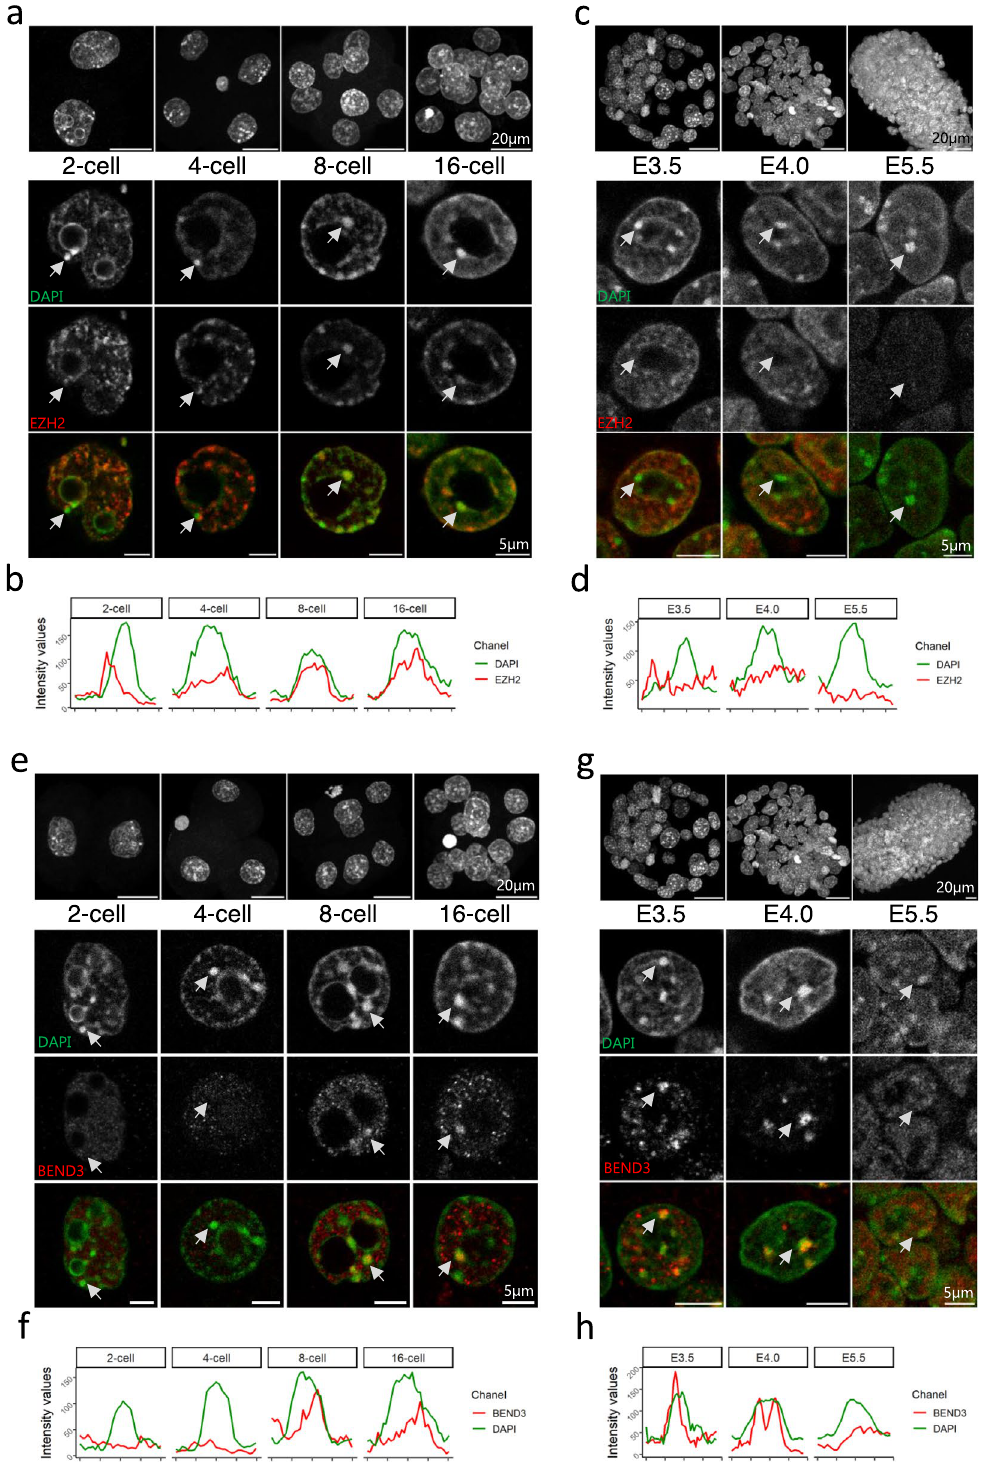
Figure 5. Patterns of EZH2 and BEND3 during peri-implantation development. ( a , c ) Upper panels show the Z-projection of a whole embryo at 2-, 4-, 8- and 16-cell ( a ) and at E3.5, E4.0 and E5.5 ( c ). Lower panels show a representative nucleus at each stage after staining with DAPI (green) and EZH2 (red). Arrows point to a chromocenter using to draw the intensity profile shown in ( b ) and ( d ). ( e , g ) Upper panels show the Z-projection of a whole embryo at 2-, 4-, 8- and 16-cell ( e ) and at E3.5, E4.0 and E5.5 ( g ). Lower panels show a representative nucleus at each stage after staining with DAPI (green) and BEND3 (red). Arrows point to a chromocenter using to draw the intensity profile shown in ( f ) and ( h ). Graphs were generated using ggplot2 56 (v3.3.5) in R and figures were arranged with FigureJ 55 in Fiji 54